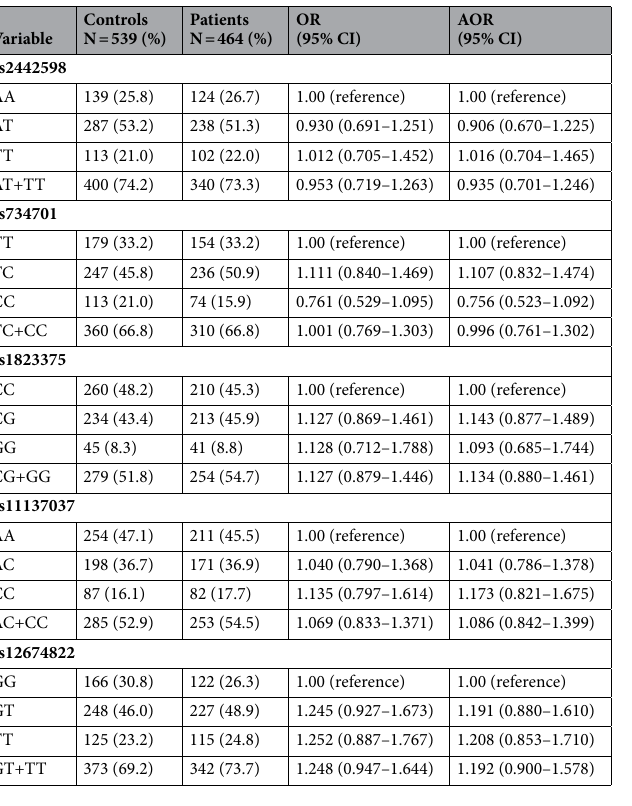
Table 2. Distribution frequencies of ANGPT2 genotypes in controls and patients with malignant breast neoplasms. The odds ratios (ORs) and their associated 95% confidence intervals (CIs) were estimated by logistic regression analysis. The adjusted odds ratios (AORs) with their associated 95% CIs were estimated by multiple logistic regression analysis that controlled for age. * p < 0.05 was considered to be statistically